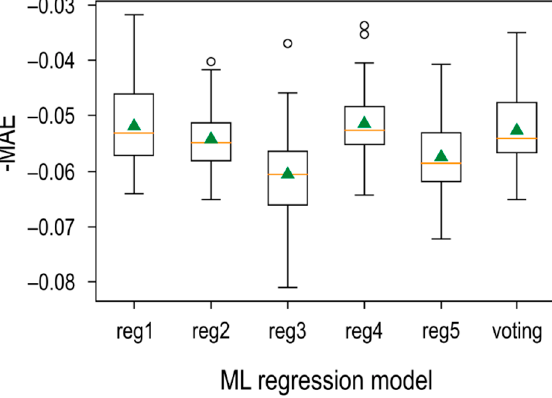
Figure 7. Boxplots of kaolinite ML model evaluation.